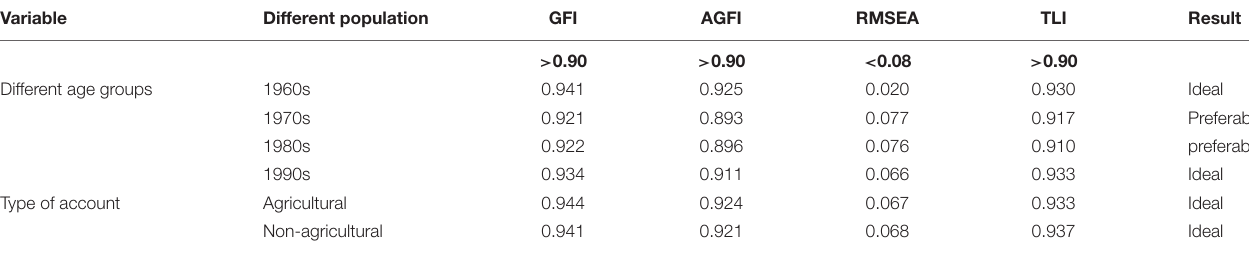
TABLE 7 | Comparison of parameters between different groups. Variable